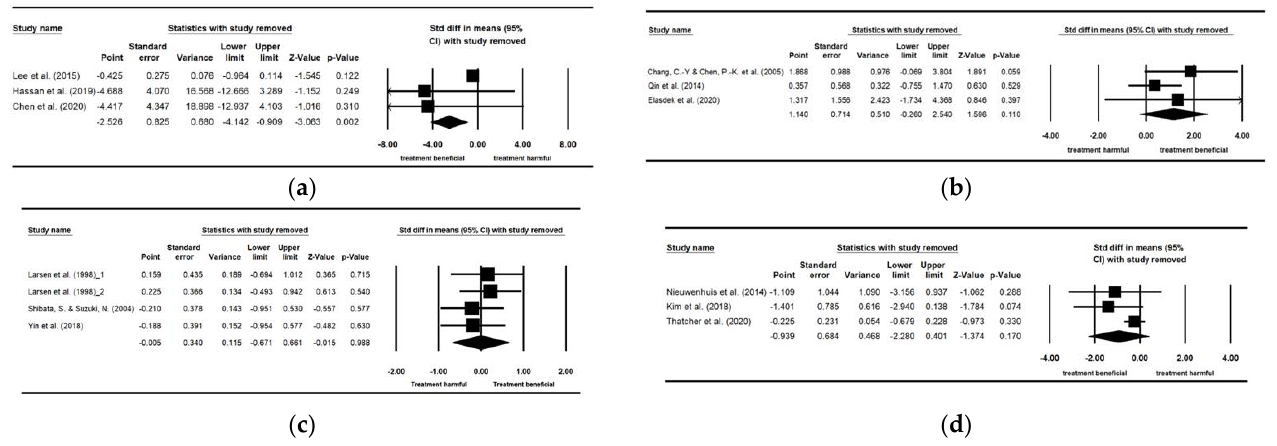
B ecause both EEG β waves and academic achievement each has only two studies, their forest plots of sensitivity anal- yses are the same as the forest plots. Figure 9. Forest plots of sensitivity analyses. ( a ) DBP [60,76,82]; ( b ) EEG α waves [56,72,81]; ( c ) at-